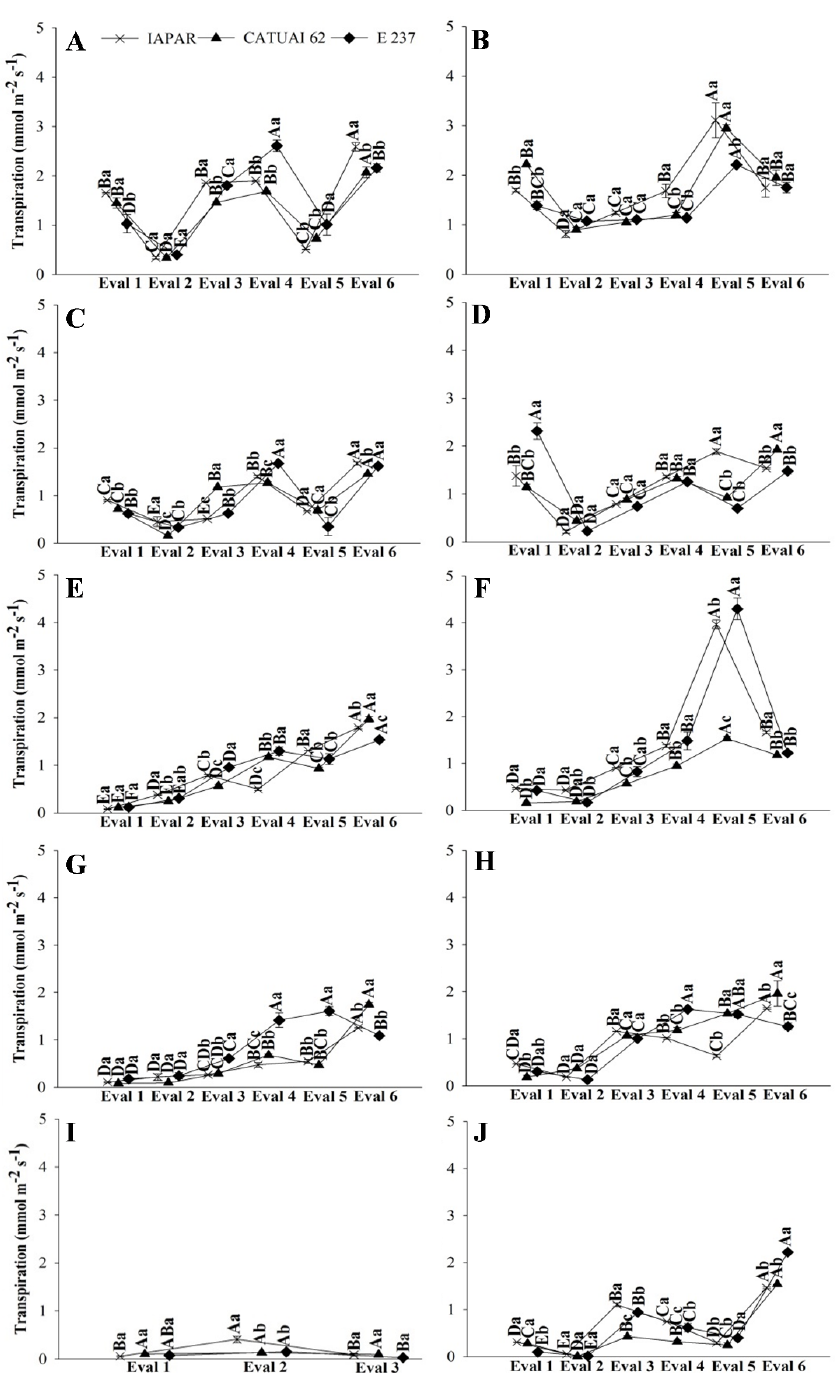
Figure 2. Transpiration of coffee leaves under water stress (Eval 1) and after the return of irrigation (Eval 2 to 6), in 2019 and 2020, of three genotypes of arabica coffee (Iapar 59, Catuaí 62 and E237) subjected to five water regimes (FI 100 ( A , B ), FI 50 ( C , D ), WD 100 ( E , F ), WD 50 ( G , H ) and rainfed ( I , J )). Capital letters compare the water regimes for each cultivar and lowercase letters compare the cultivars of each water regime. Means followed by the same letter do not differ according to the Tukey test at 5% probability. FI 100 and 50 (full irrigation with 100% and 50% replacement of evapotranspiration); WD 100 and 50 (water deficit with the suspension of irrigation from June to September, with replacement of 100% and 50% of evapotranspiration, respectively); rainfed (without irrigation).